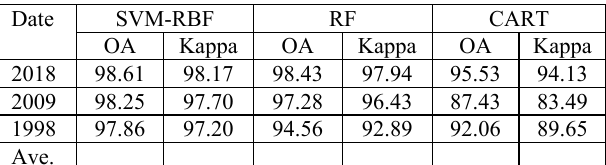
Table 6. Classification and accuracy assessment of UP